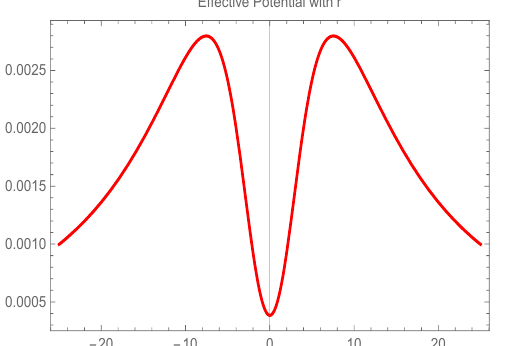
Figure 1. Variation of the effective potential with r for β = 5, M = 1, L = 1, and ξ =